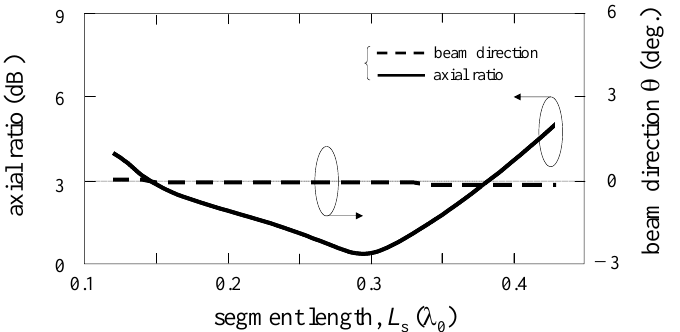
Figure 5. Simulated beam direction and axial ratio versus segment length L s for a branched line antenna with N = 12.